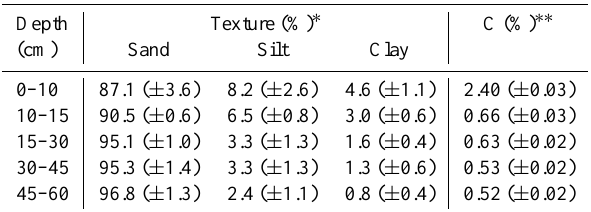
Table 1. Textural composition and organic carbon content of the soil in a deciduous forest.